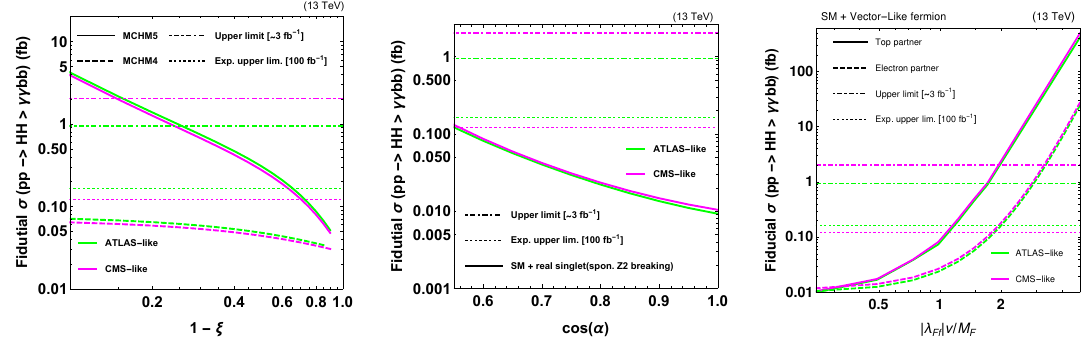
Figure 5 . Predictions of the one-parameter models in table 5 and 95% CL exclusion bounds. See text for